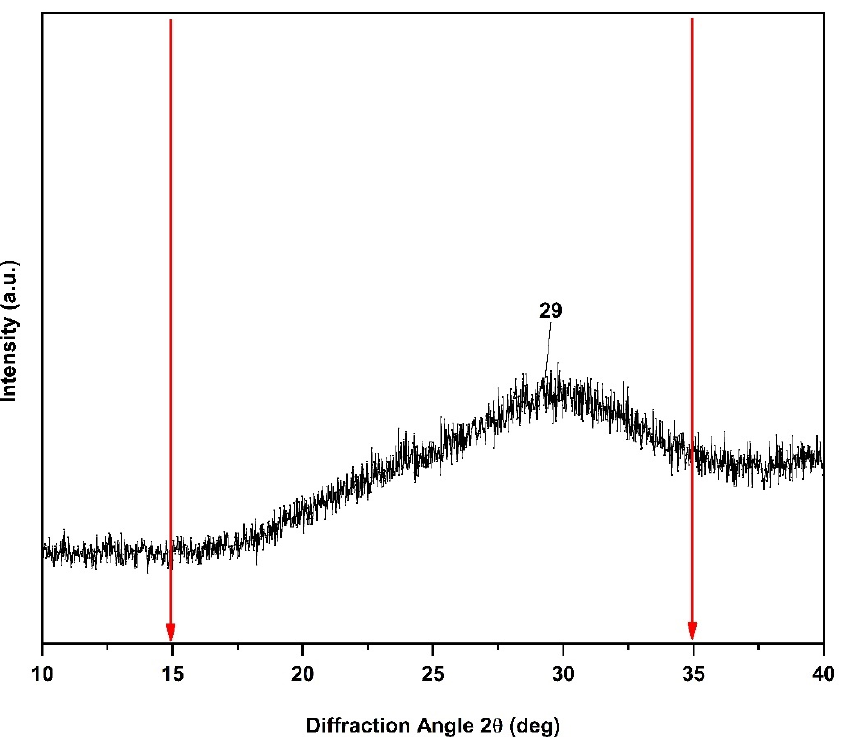
Figure 2. XRD patterns of the n-BGs.